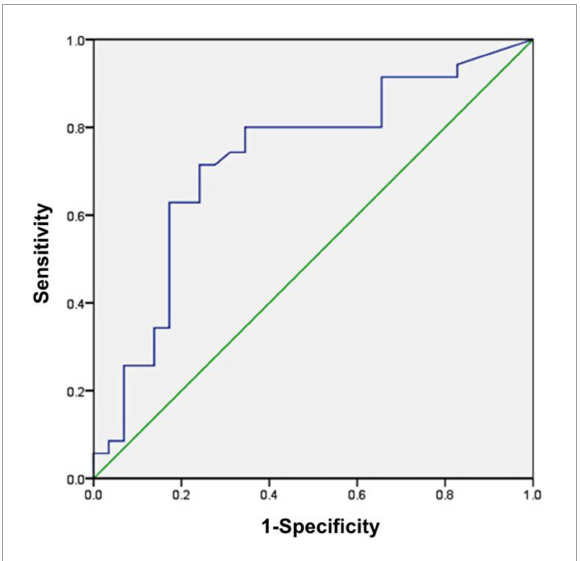
FIGURE3 Receiver operating characteristic (ROC) curve analysis of serum IL-12p40 as a biomarker for the prediction of minimal change disease (MCD) relapse. The area under the ROC curve was 0.727 (95%CI: 0.597–0.856; P < 0.01), demonstrating that IL-12p40 was a suitable marker for predicting the relapse of